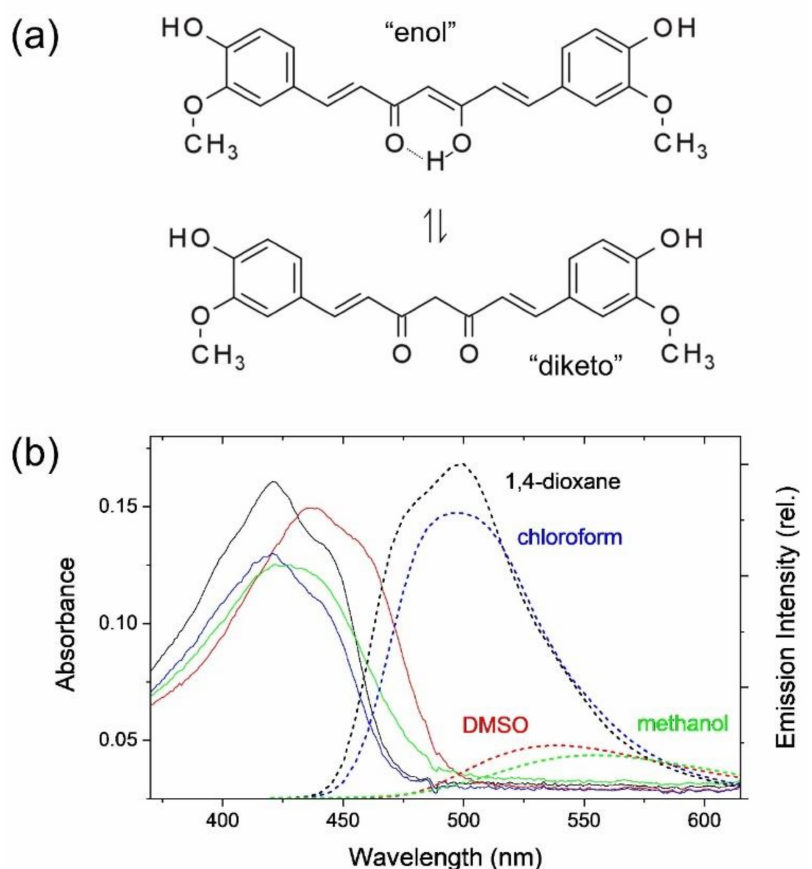
Figure 1. ( a ) Molecular structure of (1 E ,6 E )-1,7-bis(4-hydroxy-3-methoxyphenyl)hepta-1,6-diene-3,5- dione (curcumin) in enol and diketo forms, ( b ) absorption (solid lines) and emission (dotted lines) spectra of curcumin in 1,4-dioxane, chloroform, DMSO, and methanol solutions. A relative (rel.) intensity scale was used for the emission